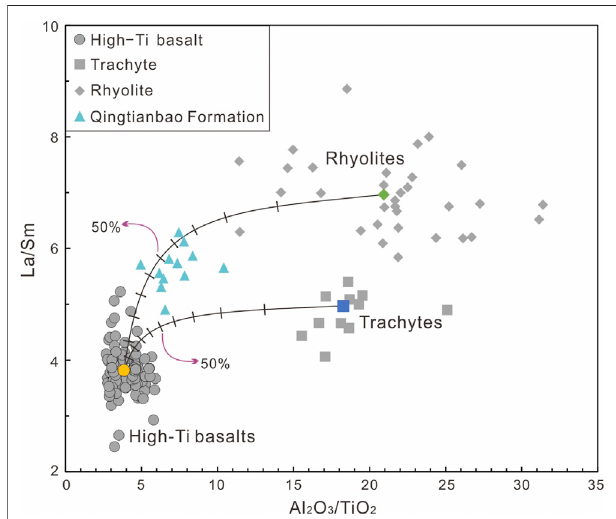
FIGURE 11 | Bivariate plot of Al 2 O 3 /TiO 2 vs. La/Sm for mudstone samples of the Qingtianbao Formation with two end-member mixing lines (Yang et al., 2015) using average values of Emeishan high-Ti basalts (Xu et al., 2001; Xiao et al., 2003, 2004; Fan et al., 2008; Song et al., 2008; Anh et al., 2011; Lai et al., 2012; Huang et al., 2014), Emeishan rhyolites (Xu et al., 2010;Chengetal.,2017;Heietal.,2018;Huangetal.,2022a),andEmeishan trachytes (Shellnutt and Jahn, 2010; Xu et al., 2010) shown for